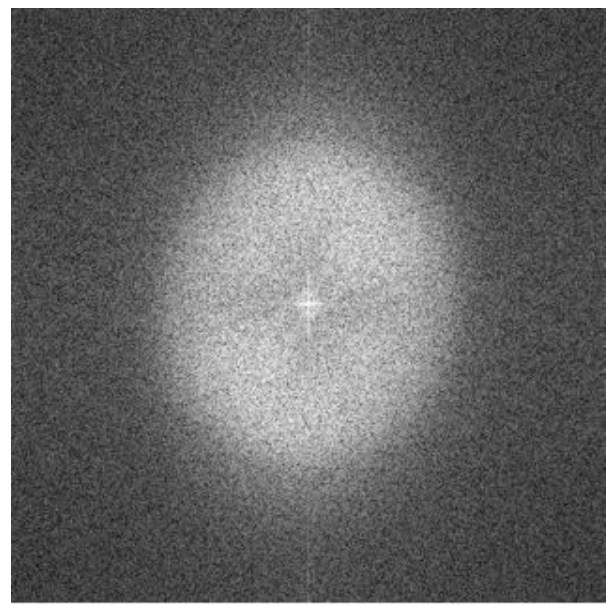
Figure 4. Fast Fourier Transform (FFT) image from area A showing non-definitive, amorphous area.